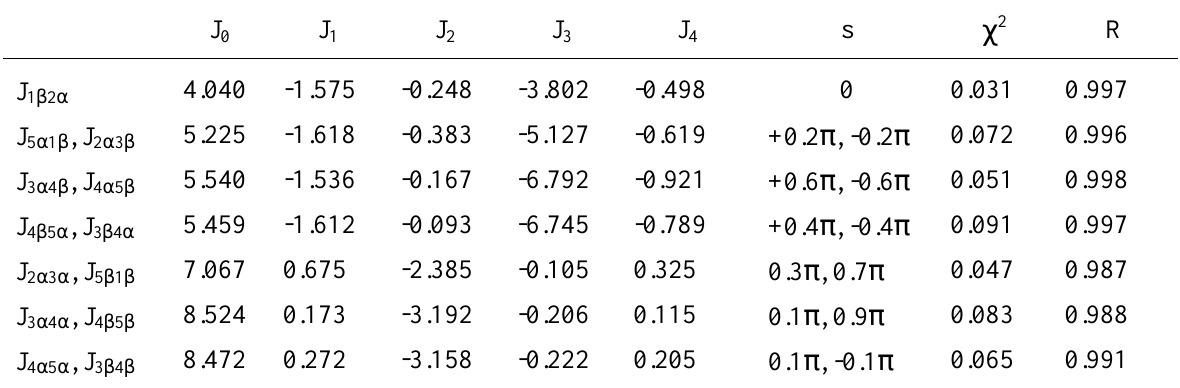
Table 3. Pseudorotation angle dependency parameters for vicinal SSCCs in trans-1,2-dichloro- cyclopentane